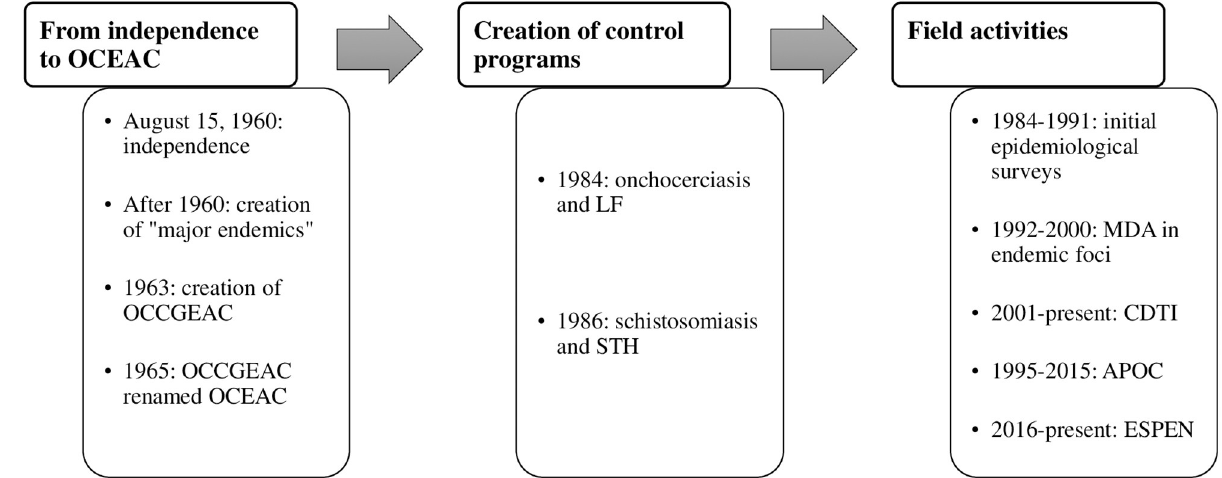
Fig 3. History of national control programs for